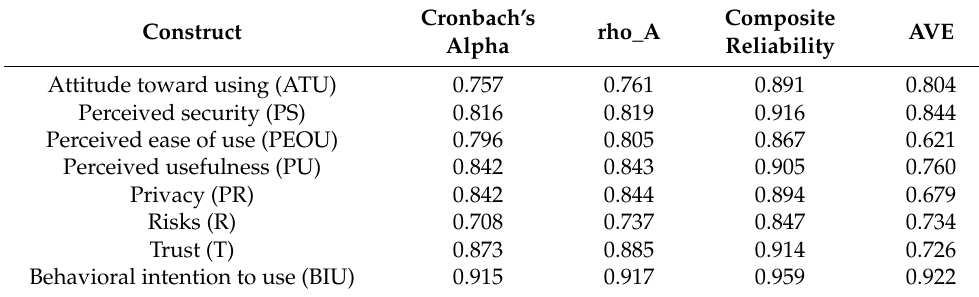
Table 4. Discriminant validity.